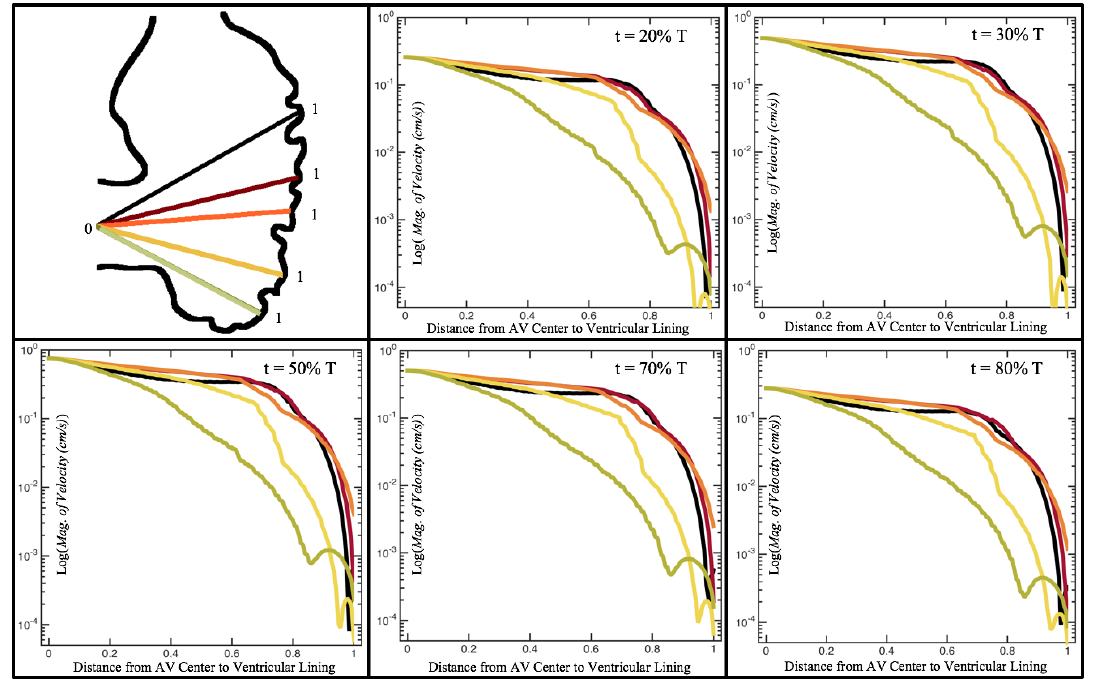
Figure 12. Plots showing how the log magnitude of velocity decays from the center of the AV canal to the ventricle wall for five different lines across the chamber using a 7 dpf ErbB2 -inhibited embryo’s geometry at Re = 1. The velocity decays until it reaches a trabeculae height away from the ventricle wall. Within pronounced trabecular valleys, the velocity increases before decaying further when measured closer to the ventricular lining. Each sub-figure corresponds to a different time during the pulsation cycle, described by a percentage of the pulsation period, T